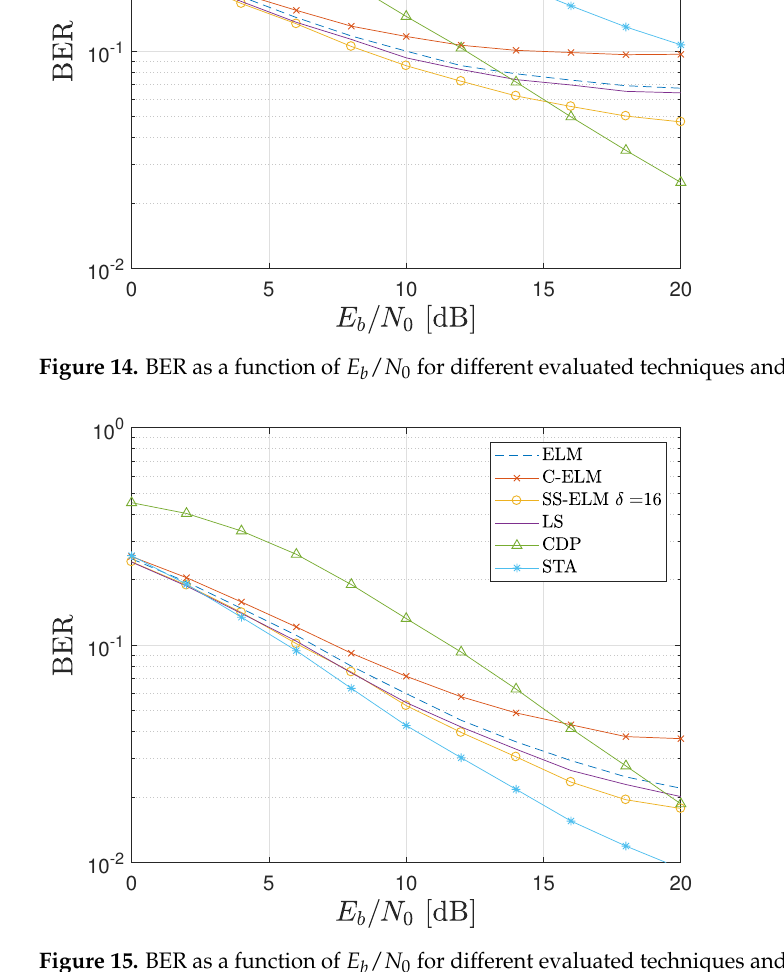
Figure 15. BER as a function of E b / N 0 for different evaluated techniques and system configuration